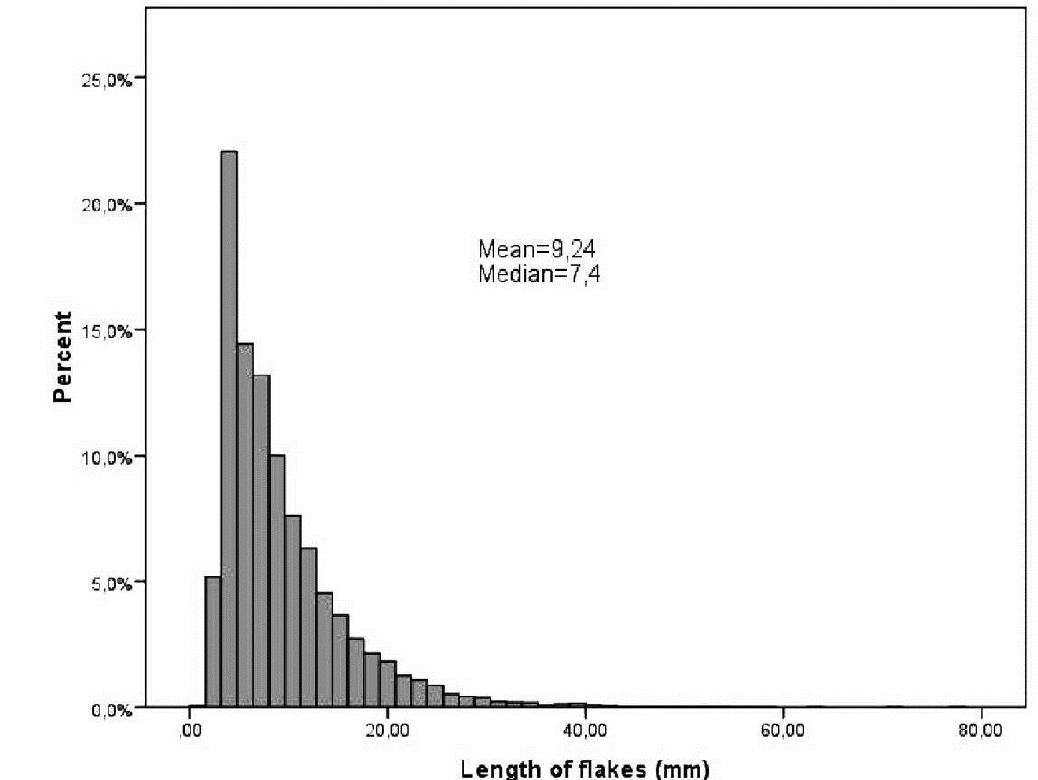
Figure 12. Flake length distribution in Derevyannoye XVIII